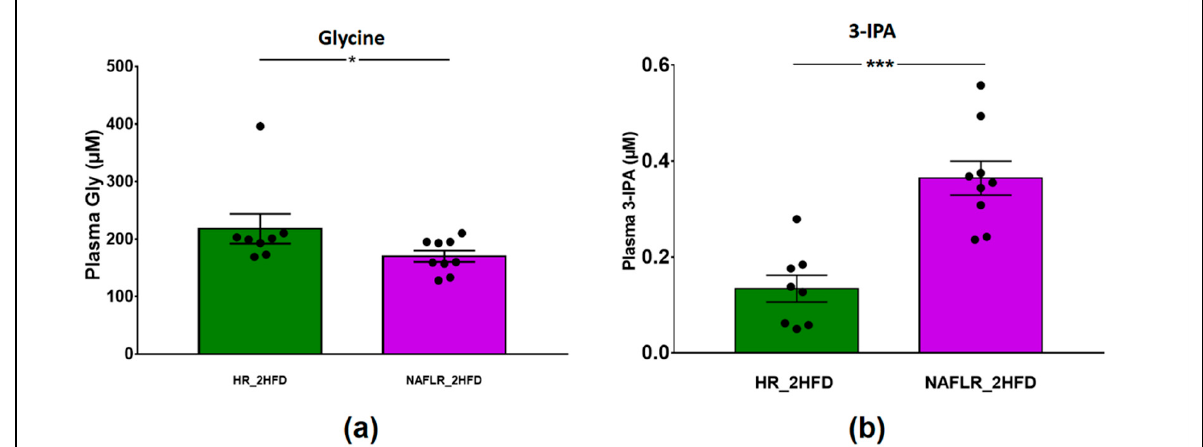
Figure 8. Metabolomic analysis of plasma in HR_2HFD and NAFLR_2HFD mice, n = 12 mice/group. ( a ) Plasma glycine (µM); ( b ) plasma 3-IPA (µM). 3-IPA, 3-Indolepropionic acid; HR, healthy human microbiota receiver mice; CD, control diet; 2HFD, high-fructose, high-fat diet; NAFLR, NAFL patient microbiota receiver mice; light green, HR_CD, HR mice on CD; dark green, HR_2HFD, HR mice on 2HFD; purple, NAFLR_2HFD, NAFLR mice on 2HFD; (* p < 0.05, *** p < 0.001) were used for statistical comparisons.